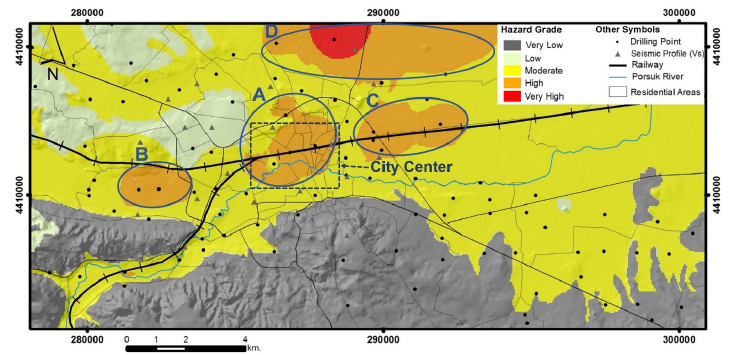
Figure 9. Hazard map produced through overlaying of liquefaction and amplification values on a given rate: high seismic risk: area A; high population with high seismic hazard; moderate seismic risk: areas B and C; significant population with high seismic hazard and low seismic risk: area D; almost no population with very high seismic